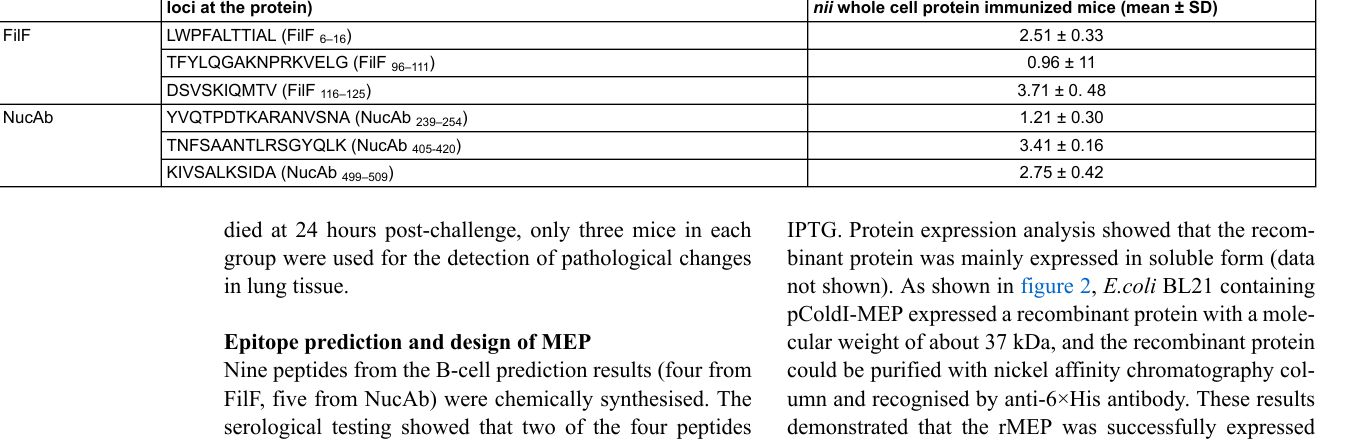
Table 2: Detection of the synthetic peptides induced proliferation of splenocytes from A.baumanni i whole cell protein immunised mice. Antigen Peptides synthesized according to the T-cell epitope prediction (amino acid loci at the protein)